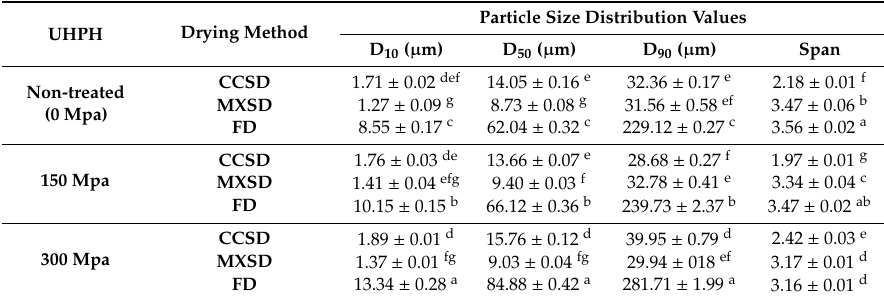
Table 3. Particle size distribution of probiotic powders containing L. plantarum NRRL B-1927 † . UHPH Drying